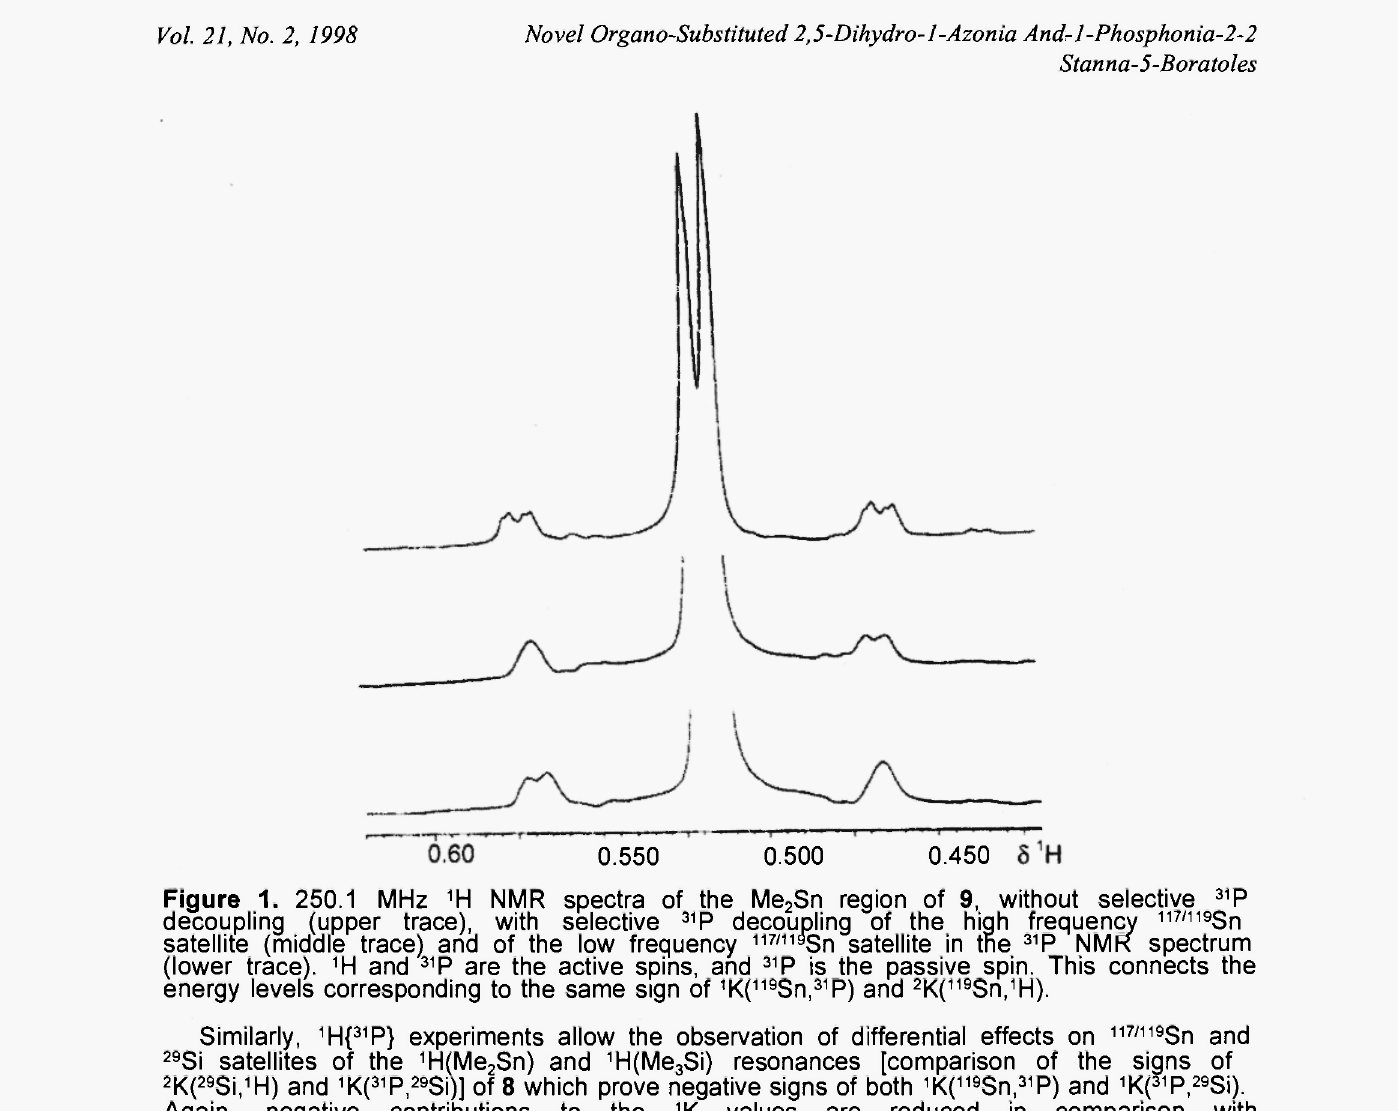
Table 3. Coupling constants (± 0.5 Hz), absolute signs of coupling constants and 13 C, 29 Si, 31